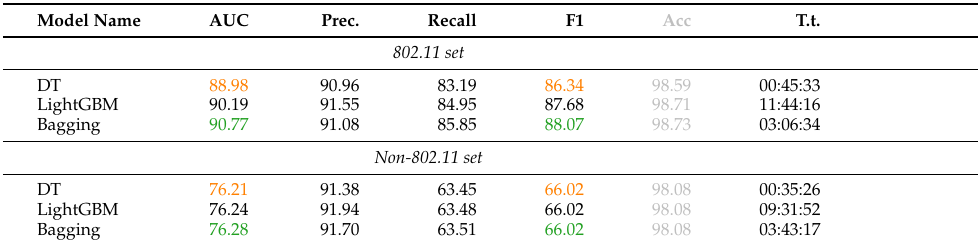
Table 4. Results of swallow classification on each feature set. Best and worse AUC and F1 scores are shown in green or orange text, respectively. The term T.t. in the rightmost column stands for total execution time, i.e., training and testing.